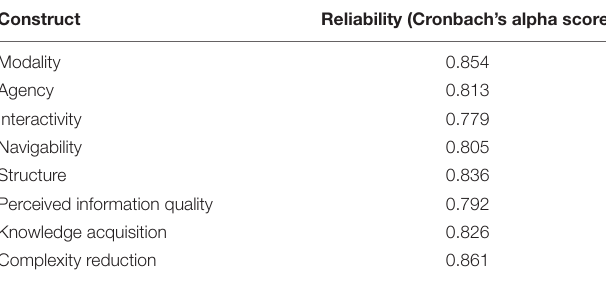
TABLE 1 | Cronbach’s alpha score for each construct. TABLE 2 | Cronbach’s alpha, composite reliability and average variance extraction (AVE) for each construct.